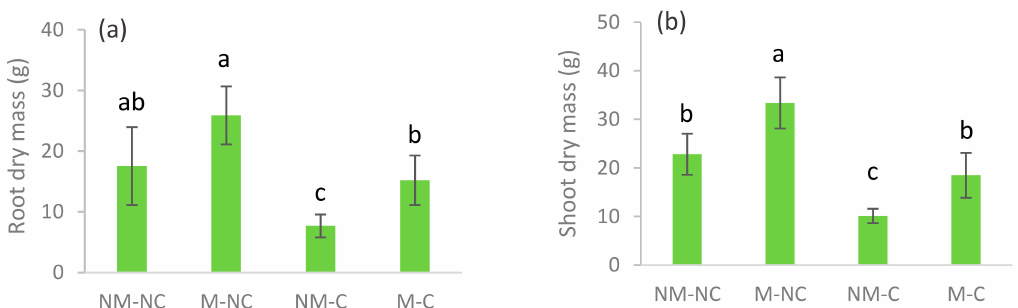
Figure 2. Root dry mass ( a ) and shoot dry mass ( b ) of ectomycorrhizal (M) and non-ectomycorrhizal (NM) P. halepensis seedlings after 12 months of exposure to contaminated (C) and control soil (NC). Means ( ± SD, n = 20) with di ff erent letters significantly di ff er from each other based on Tukey’s tests at p ≤